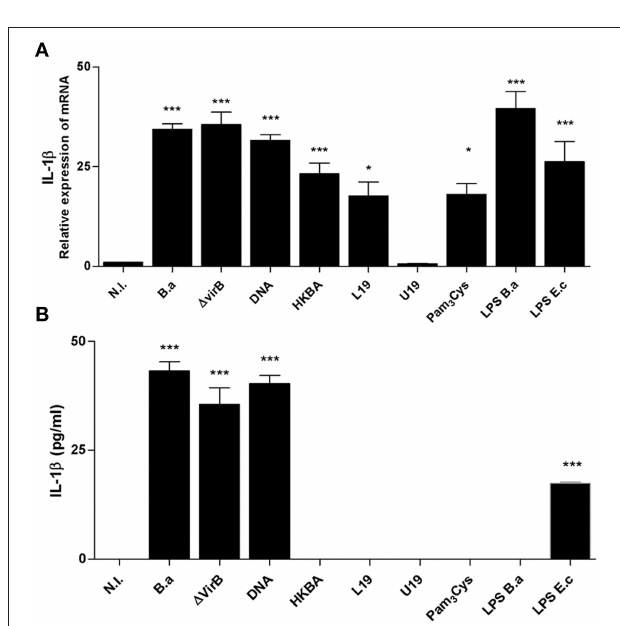
FIGURE 4 | L-Omp19 induces mRNA of IL-1 β . (A) LX-2 cells were infected with B. abortus ( B.a ) and its virB10 isogenic mutant ( 1 vir B10) at MOI 1000, or incubated with DNA (2 µ g/ml), heat-killed B. abortus (HKBA) (1 × 10 6 and 1 × 10 8 bacteria/ml), L-Omp19 (1,000ng/ml), U-Omp19 (1,000ng/ml), B. abortus LPS (1,000ng/ml), Pam 3 Cys (50ng/ml), or E. coli LPS (100ng/ml). Determination of IL-1 β mRNA by RT-qPCR (A) and IL-1 β secretion by ELISA (B) . Data are given as the means ± SD from at least three individual experiments. * P < 0.05; *** P < 0.001 vs. non-infected cells (N.I.).